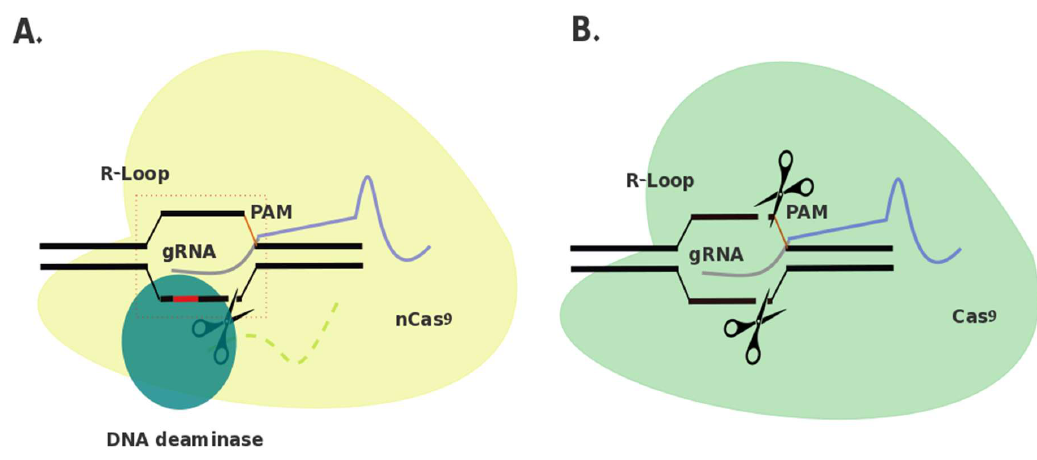
Figure 1. Comparison of base editing and clustered regularly interspaced short palindromic repeats (CRISPR) / CRISPR-associated protein 9 (Cas9) genome editing. A. Depiction of a base editor. Cas9 nickase (Cas9 D10A ; yellow) is attached through a linker (light green) to a DNA deaminase. (blue). Guide ribonucleic acid (RNA) (guide RNA (gRNA); purple / grey) guides nCas9 to site of interest, invading the double-stranded (ds) deoxyribonucleic acid (DNA) and forming an R-loop. nCas9 cleaves the target strand 3–4 bp upstream from the protospacer adjacent motif (PAM) site (orange). DNA deaminase is capable of deaminating DNA within a 5-nt window 13–17 nt upstream from the PAM site. B. Depiction of CRISPR/Cas9 genome editor. Cas9 (green) is guided to a site of interest via a gRNA (purple/grey). An R-loop is formed through invasion of the dsDNA by the gRNA and Cas9 cleaves the target strand 3–4 bp upstream from the PAM site (orange).